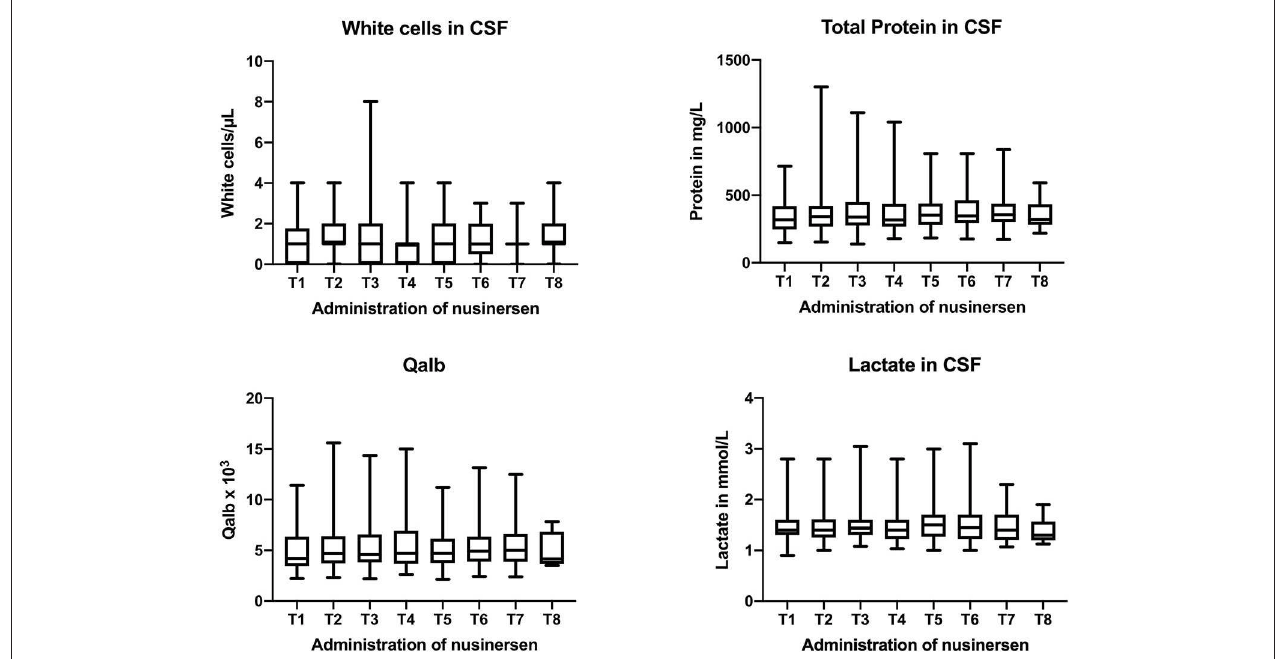
FIGURE 1 | Boxplots of routine CSF parameters (white cells, total protein, Qalb, and lactate) at all treatment days (T1–T8). Boxes give median values with quartiles, whiskers indicate the